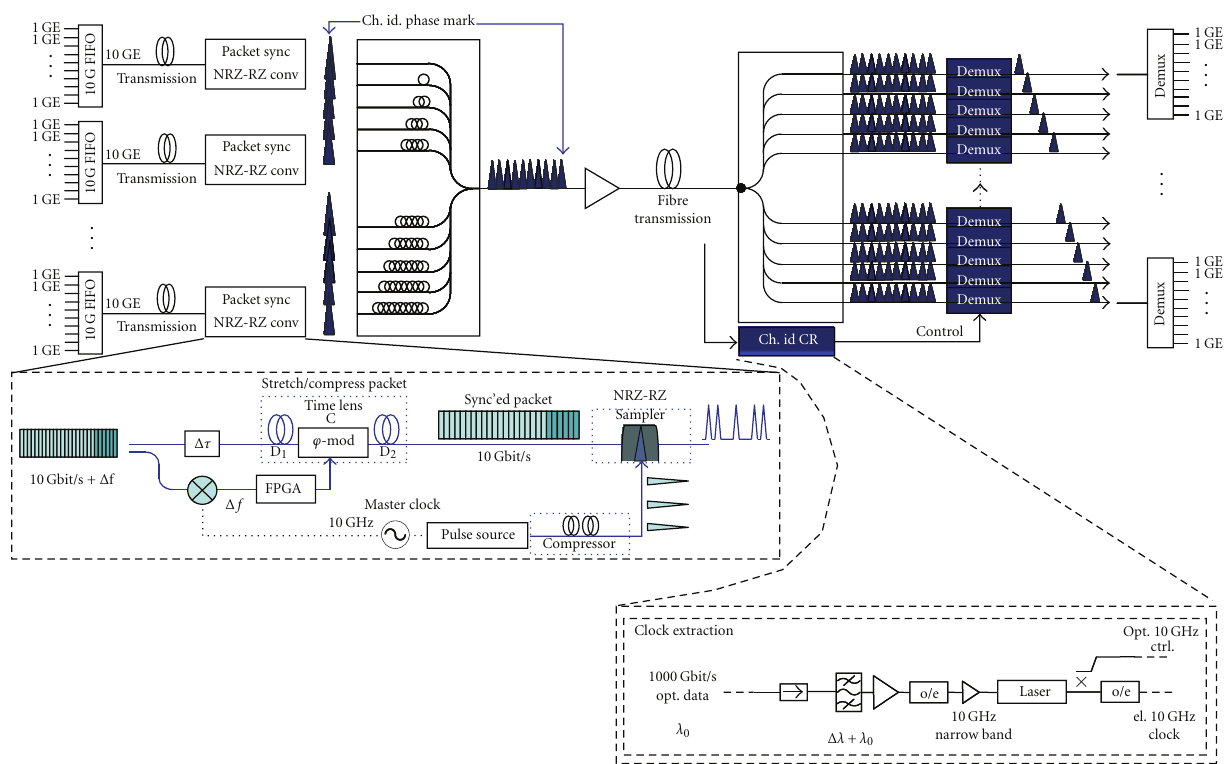
Figure 16: Suggested Ethernet compatible optical TDM system. Each 10 GE packet is synchronised to the local master clock via a time-lens- based sync unit, essentially stretching or compressing the data packet to fit the individual bits to the local rep rate. The synchronised bits in the packet are then individually converted to RZ pulses, for example, by optical sampling, allowing for subsequent time domain multiplexing, by interleaving the bits with those from other synchronised packets. Thus, each packet is ascribed its own time slot. Time slot N may also be marked with a channel ID, for example, by a slight phase modulation, allowing for easy channel identification and sub rate clock recovery at the receiver. The demultiplexing may take place in several ways and is here only conceptually shown as parallel demux-units for simplicity.